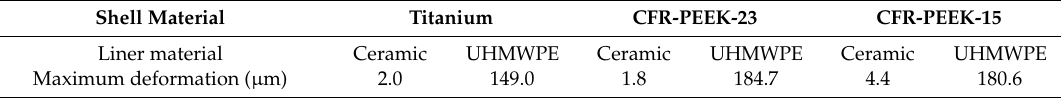
Table 3. Maximum radial liner deformations dependent on the acetabular shell and liner material. Shell Material